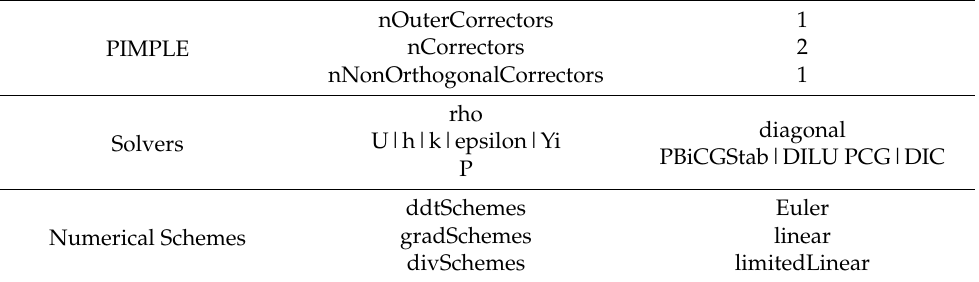
Table 1. Laboratory scale furnace simulation settings.